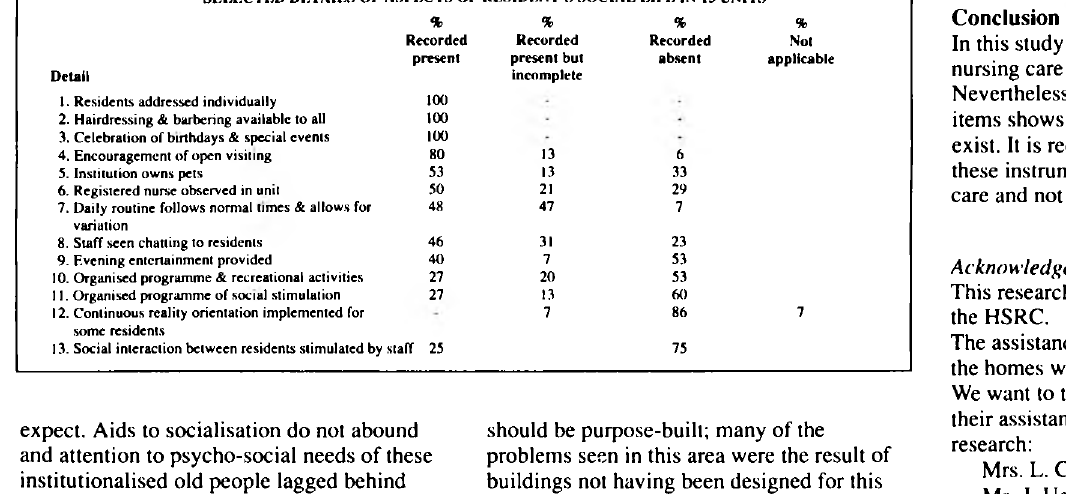
TABLE 4. SELECTED DETAILS OF ASPECTS OF RESIDENT'S SOCIAL LIFE IN 15